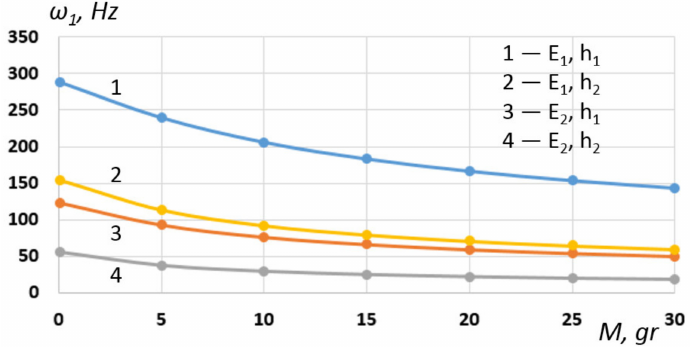
Figure 8. Dependence 1 of the first natural frequency of the PEG on various variations in the parameters of the base plank (E i —the modulus of elasticity and h i —the height of the